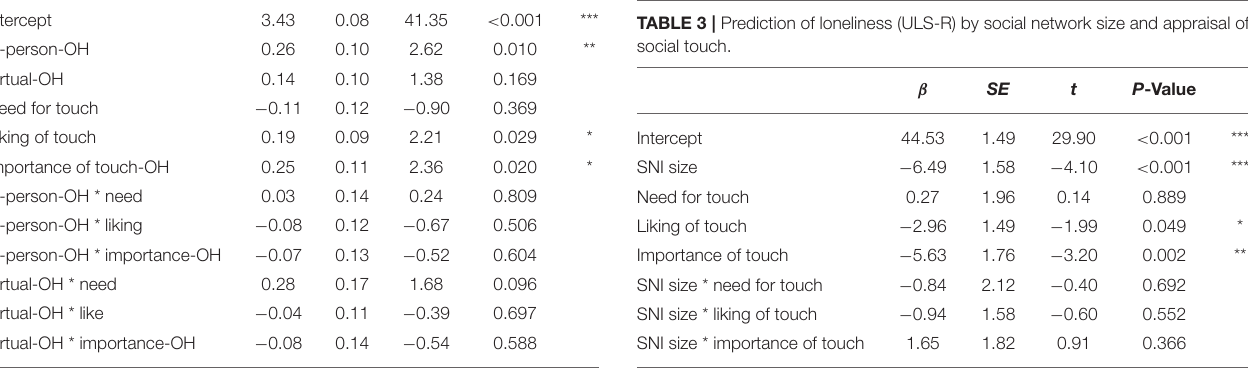
TABLE 2 | Prediction of social closeness by contact frequencies and appraisal of social touch.